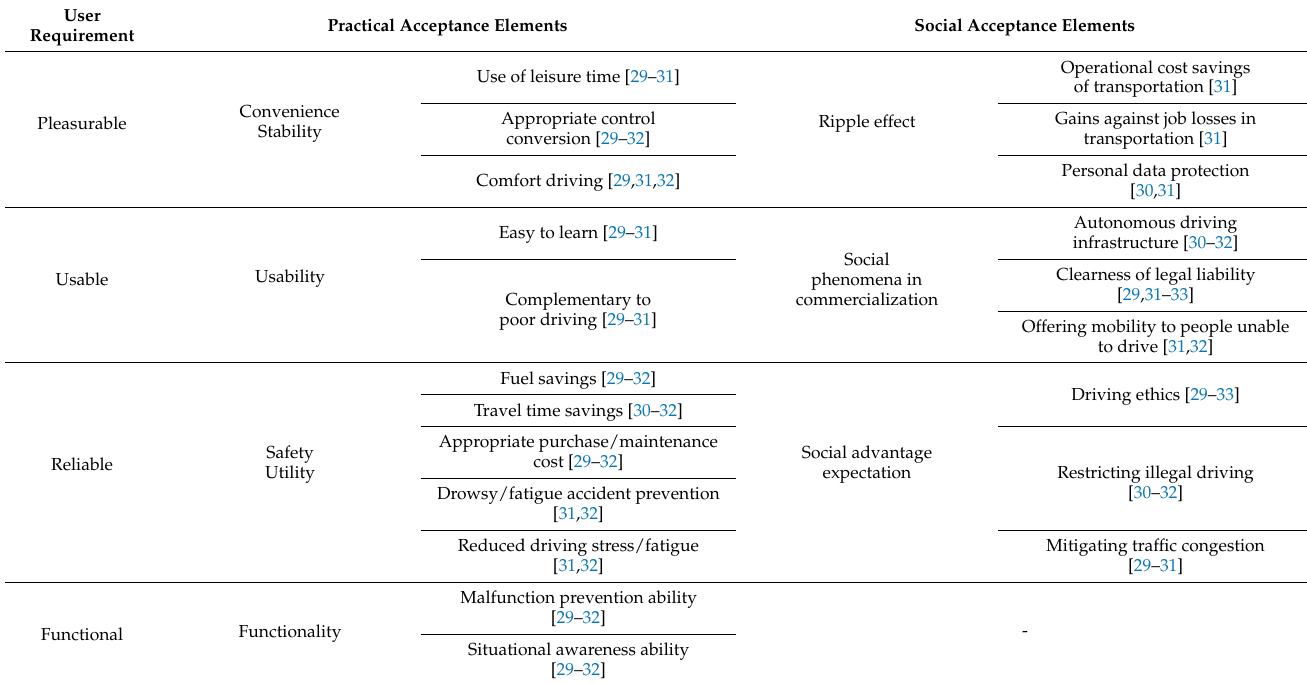
Table 3. Acceptance elements in autonomous driving